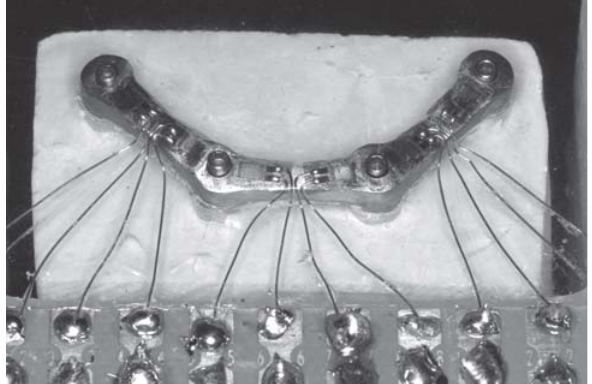
FIGURE 3- Dot plot for micro deformation (µ å ) values obtained under the different experimental